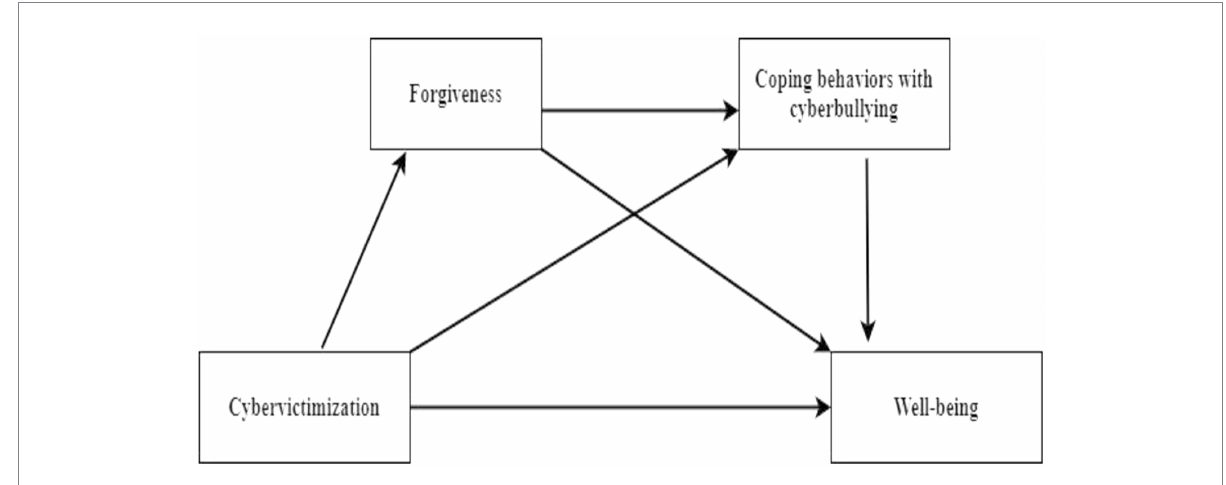
FIGURE 1 The serial multiple mediation of forgiveness and coping behaviors with cyberbullying in cyber victimization and